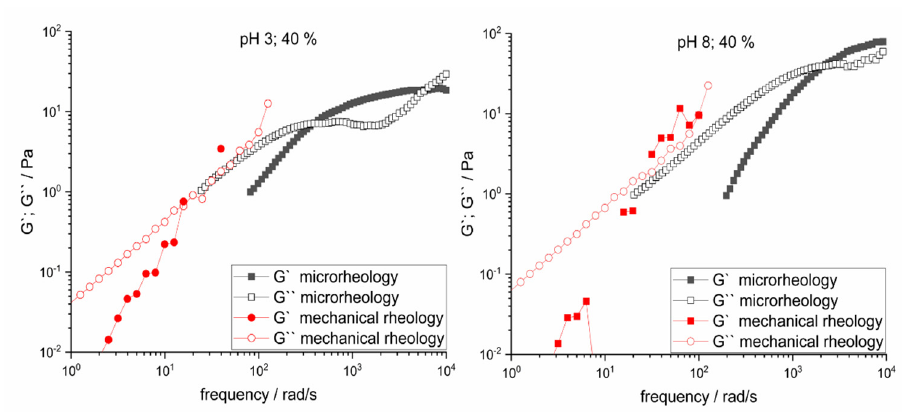
Figure 3. Combination of classical rheology and microrheology illustrating the evolution of the frequency response of G ′ (filled), G ″ (open symbols) of Sophorolipid (SL) in water at 40% concentration (w/w %) at left) pH 3 right) ph 8.